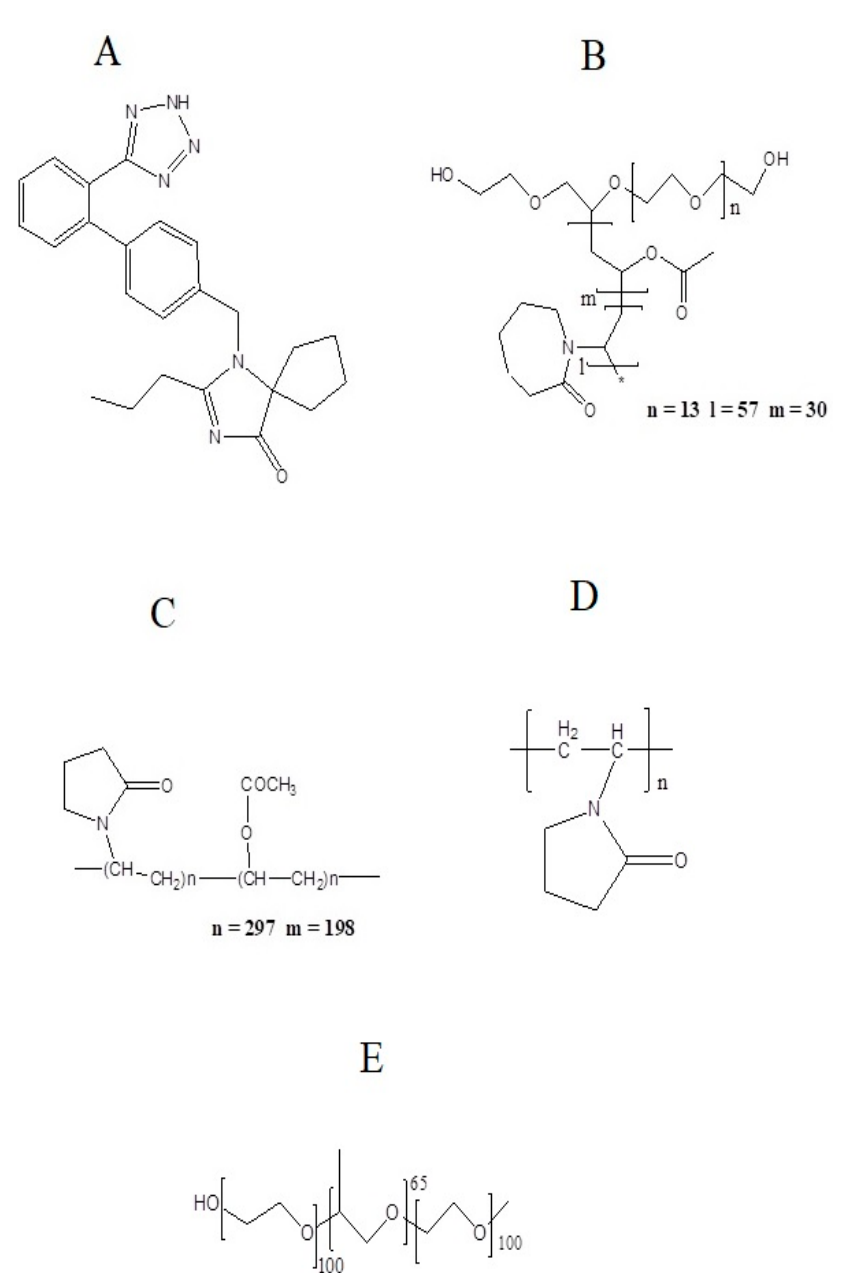
Figure 1. Structures of ( A ) Irbesartan, ( B ) Soluplus ® , ( C ) Kollidon ® VA 64, ( D ) PVP-K30 , and ( E ) Kolliphor ® P 407